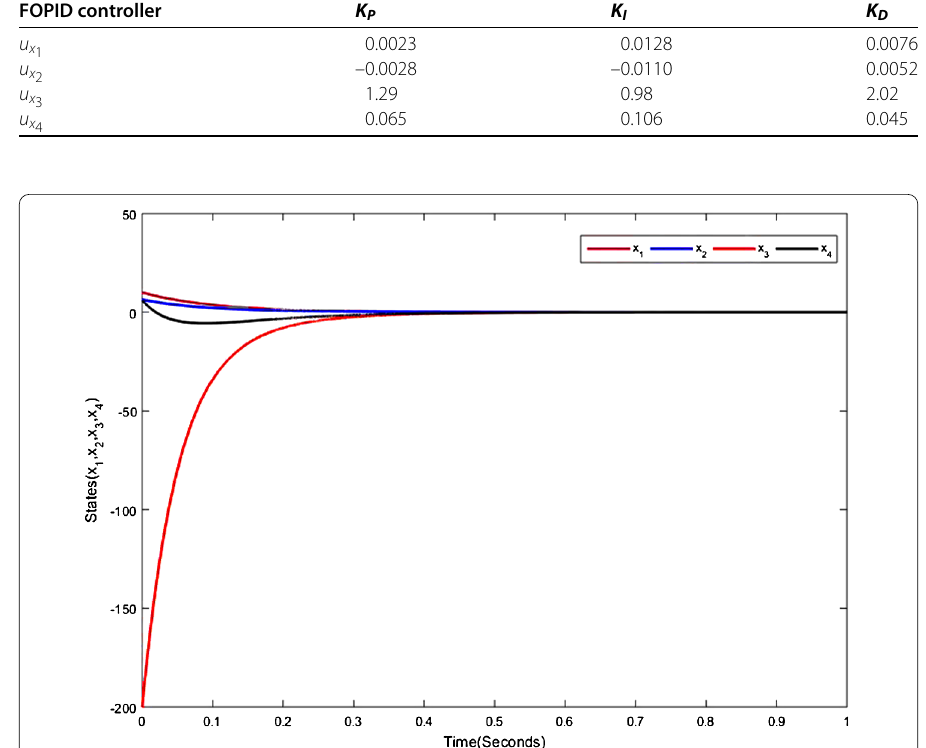
Figure 12 Time response of chaos suppression ( x 1 , x 2 , x 3 , x 4